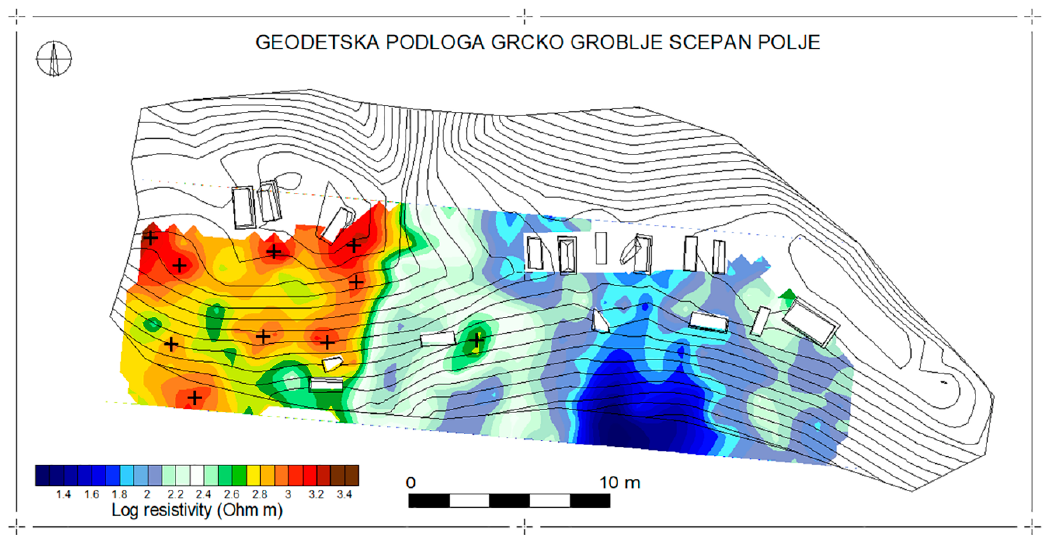
Figure 23. Ste´cci of Plužine: electrical resistivity map relative to 1 m in depth with indication of probable buried gravestones.